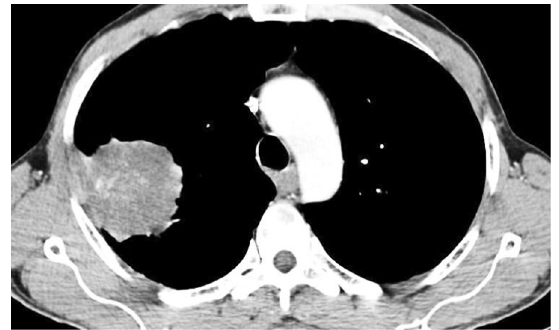
Fig. 7 50‑year‑old male patient with history of persistent cough and hemoptysis. Axial CT mediastinal window image of the right upper lung lobe showing a pleural‑based mass lesion invading the EPS (pathologically proved bronchogenic carcinoma)